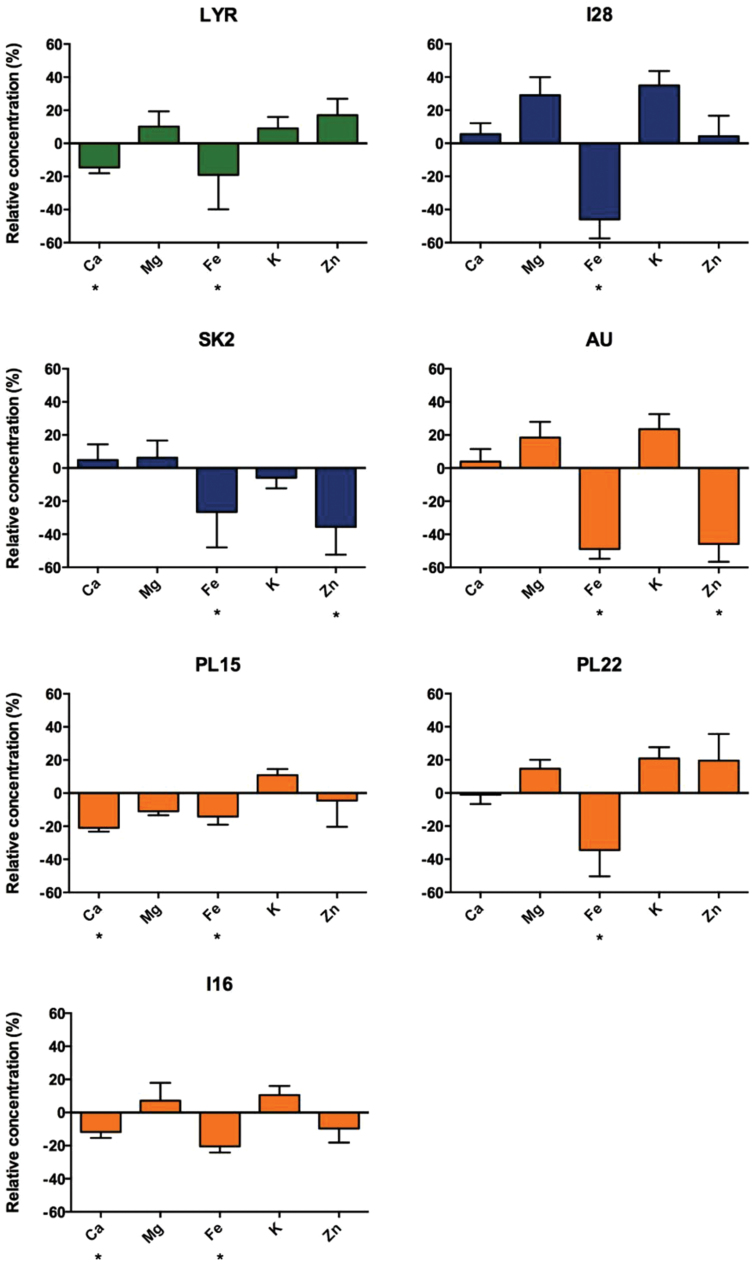
Changes in shoot mineral content of A. halleri NM (I28, SK2) and M (AU, PL15, PL22, I16) populations and A. lyrata petraea (LYR) after a 3 week exposure to 5 μM CdSO4. For each individual, the following ratio was calculated: (value in C condition - mean of the population in NC condition) / mean of the population in NC condition, and expressed in %. Data are the mean ±SD, n=7, 10, 4, 10, 11, 7, and 16; asterisks indicate statistical differences between treatments at the 5% level. (This figure is available in colour at JXB online.)